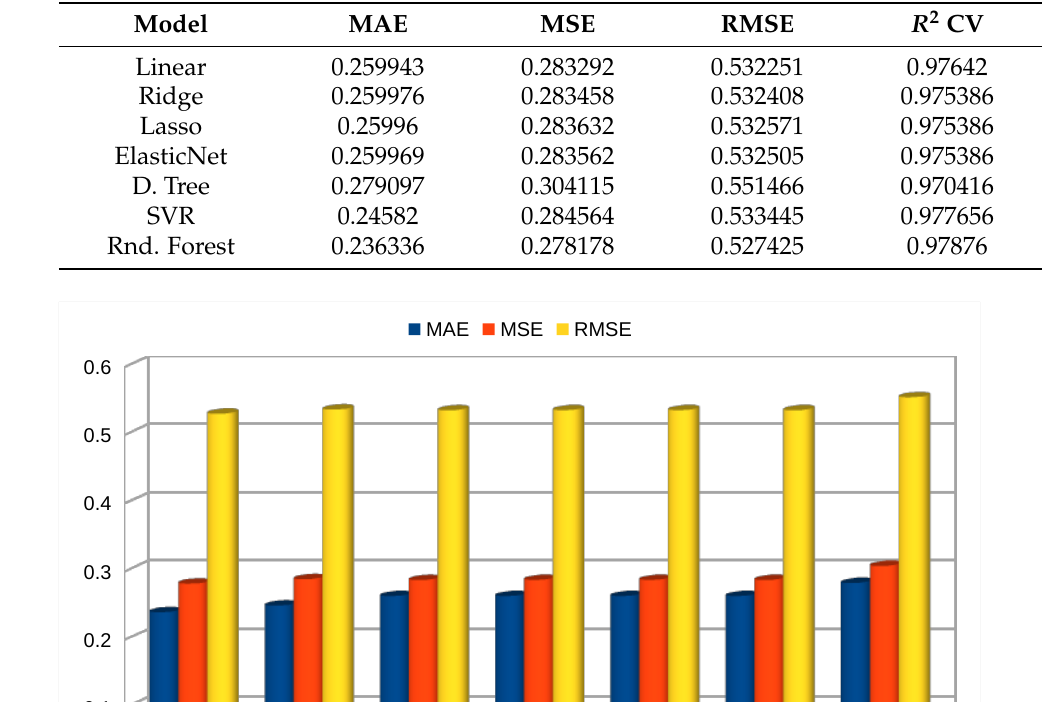
Table 3. Results of the models when they are trained with measured data.